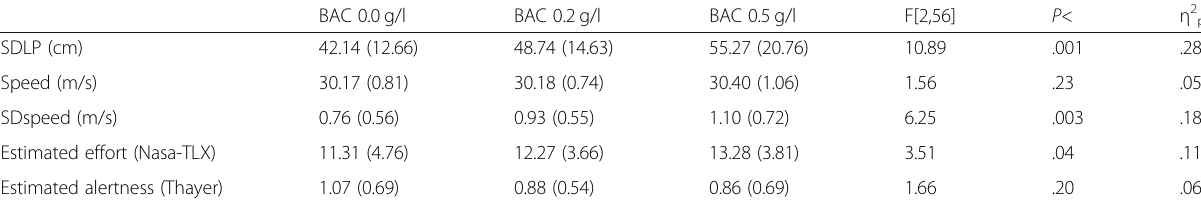
Table 3 Mean driving performance, estimated effort and estimated alertness after driving as a function of BAC (SD between brackets)